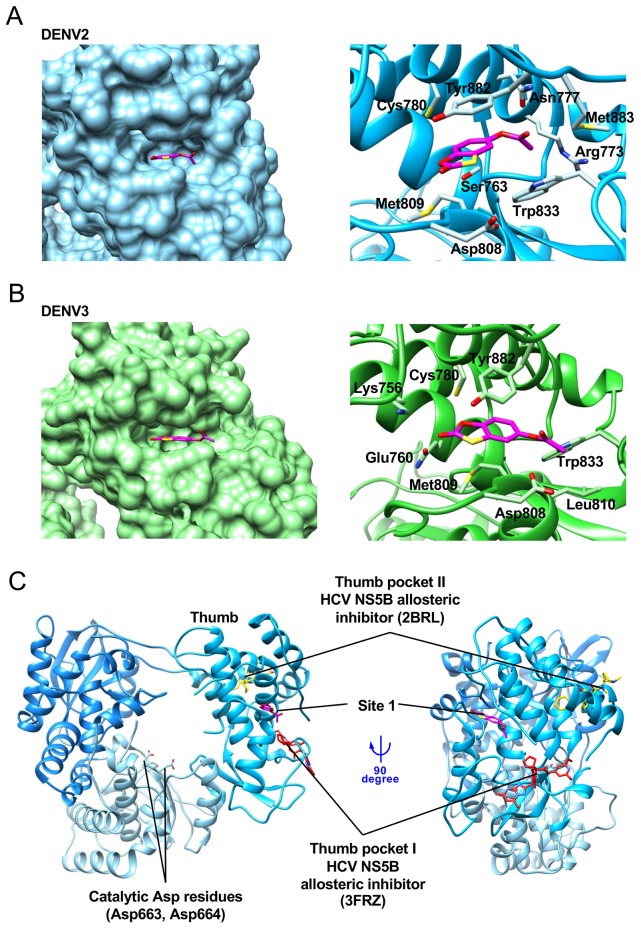
Details of the interaction between the DENV RdRps and RK-0404678 in Site 1.A. Surface (left) and ribbon-stick (right) representations of the interaction between the DENV2 RdRp and RK-0404678 in Site 1. RK-0404678 is represented by a magenta stick model. B. Surface (left) and ribbon-stick (right) representations of the interaction between the DENV3 RdRp and RK-0404678 in Site 1. C. Binding sites of allosteric inhibitors in the thumb subdomain. Allosteric inhibitors for HCV NS5 RdRp, represented by red (PDB ID: 3DRZ) and yellow (PDB ID: 2BRL) stick models, are superimposed on the structure of the RK-0404678-bound form of the DENV2 RdRp.